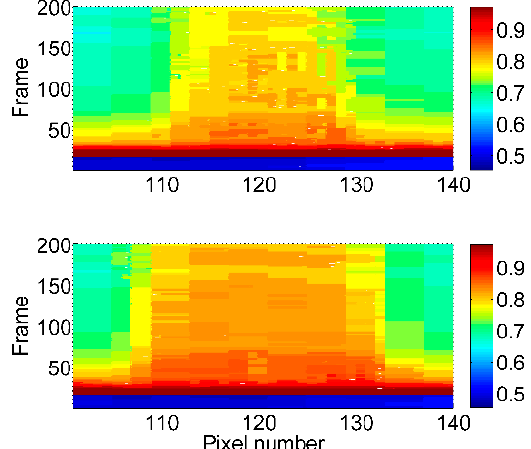
Figure 9. Pixel intensity variation along lines 62 (top) and 67 (bottom).